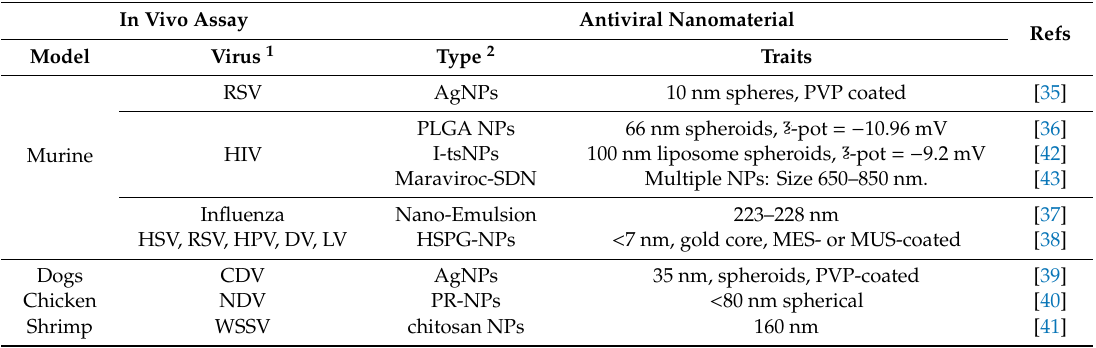
Table 2. A non-exhaustive list of examples of antiviral nanomaterials under preclinical assays in vivo. In Vivo Assay